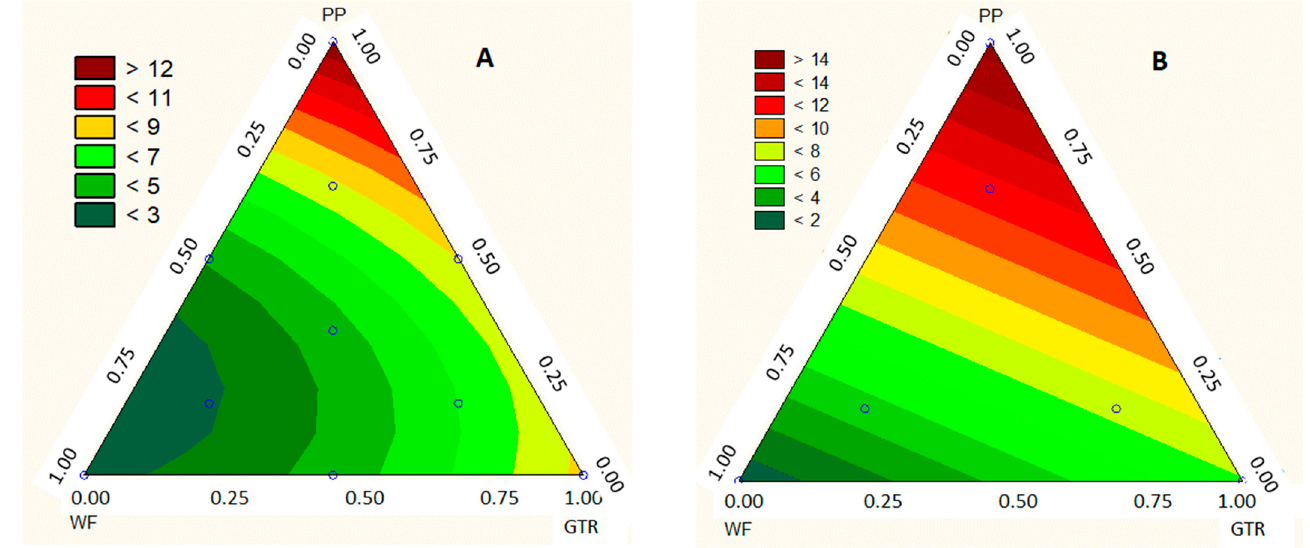
Figure 5. Elongation at break results of the untreated ( A ) and EB compatibilized ( B ) PP/GTR/WF